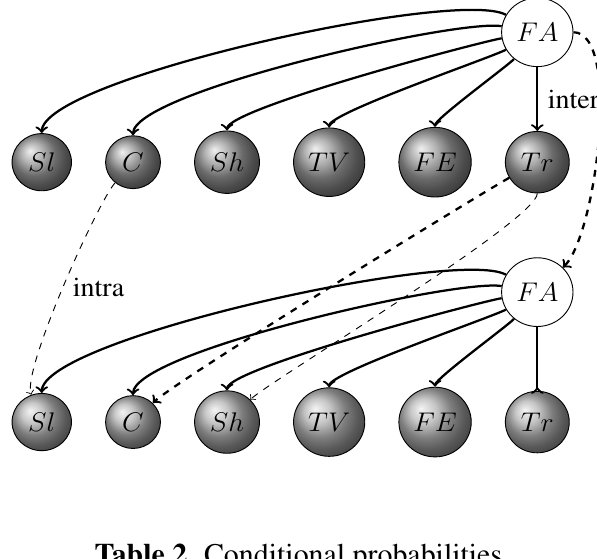
Figure 5. The system’s directed acyclic graph (DAG) unrolled for two time slices.